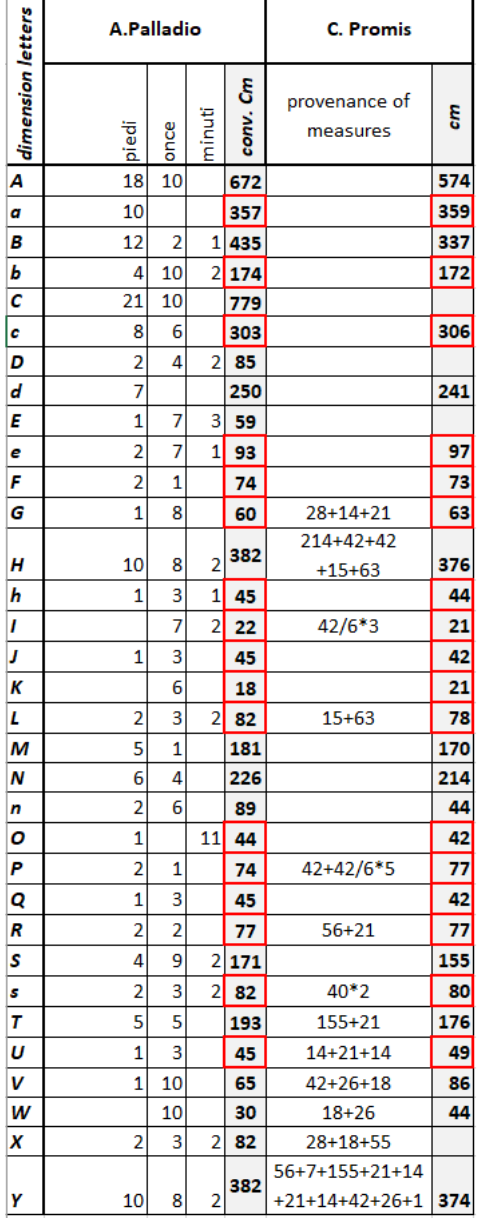
Figure 11 . Transcript of measurements and comparison between A. Palladio and C. Promis